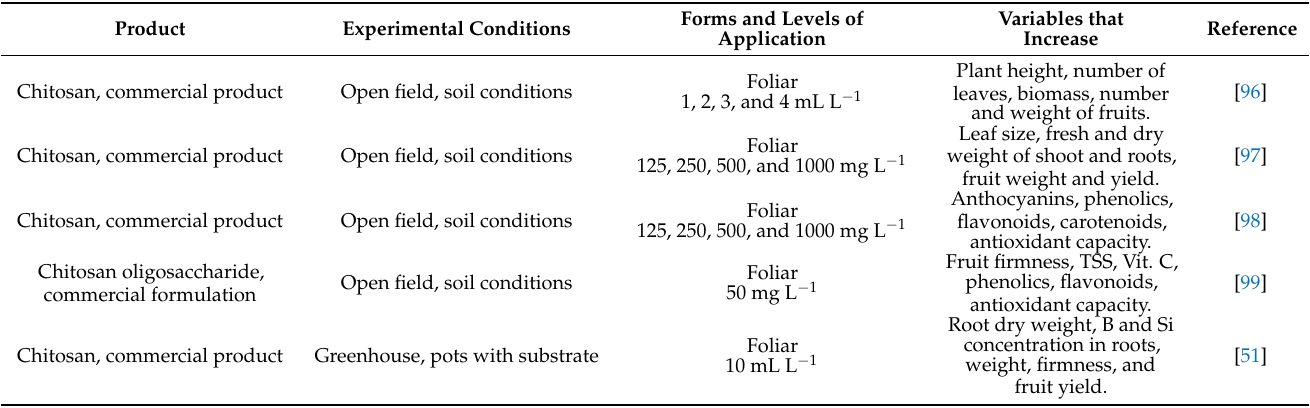
Table 4. Favorable effects of chitosan applications on some growth or quality variables of strawberry